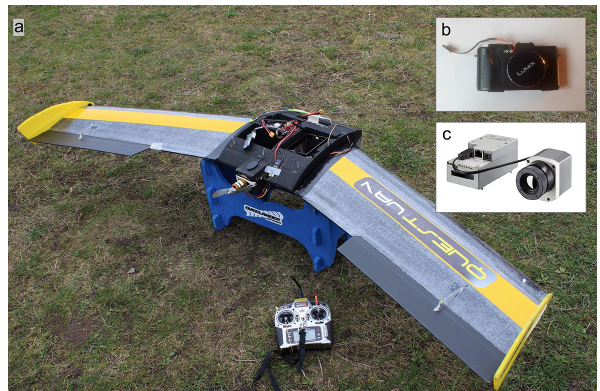
Figure 3. (a) The fixed-wing QuestUAV with a wingspan of 2m used to collect data. (b) The digital Panasonic DMC-LX5 Lu- mix camera with installed trigger cable to ensure link between the autopilot GPS positions and GPS positions of triggered images. (c) The Optris PI 450 thermal infrared